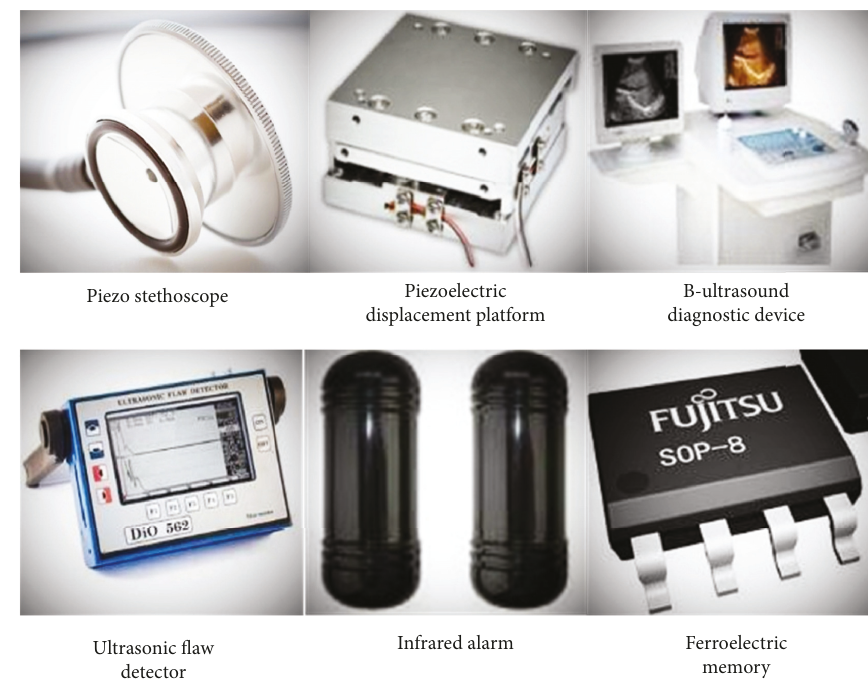
Figure 1: Application of ferroelectric